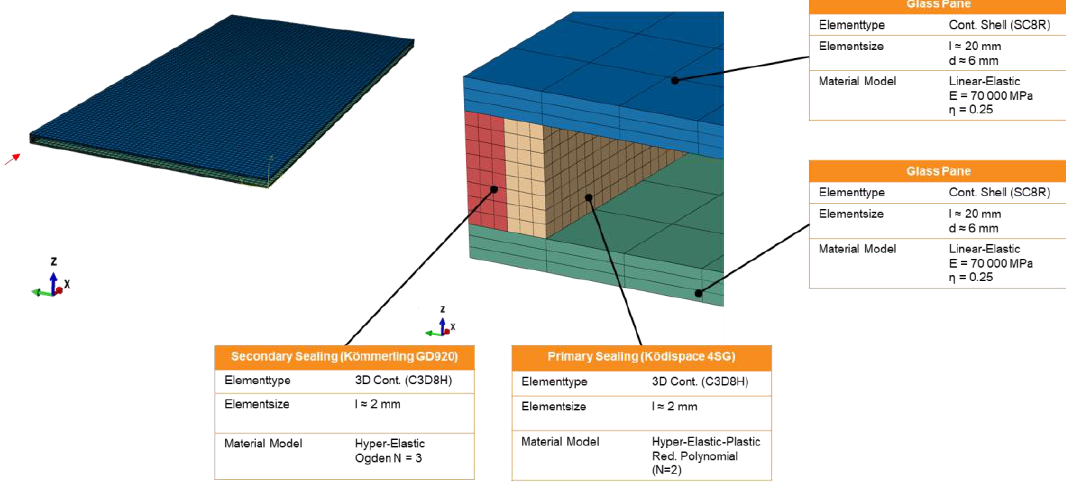
Fig. 7 FE model of the insulating glass unit with Ködispace 4SG spacer.